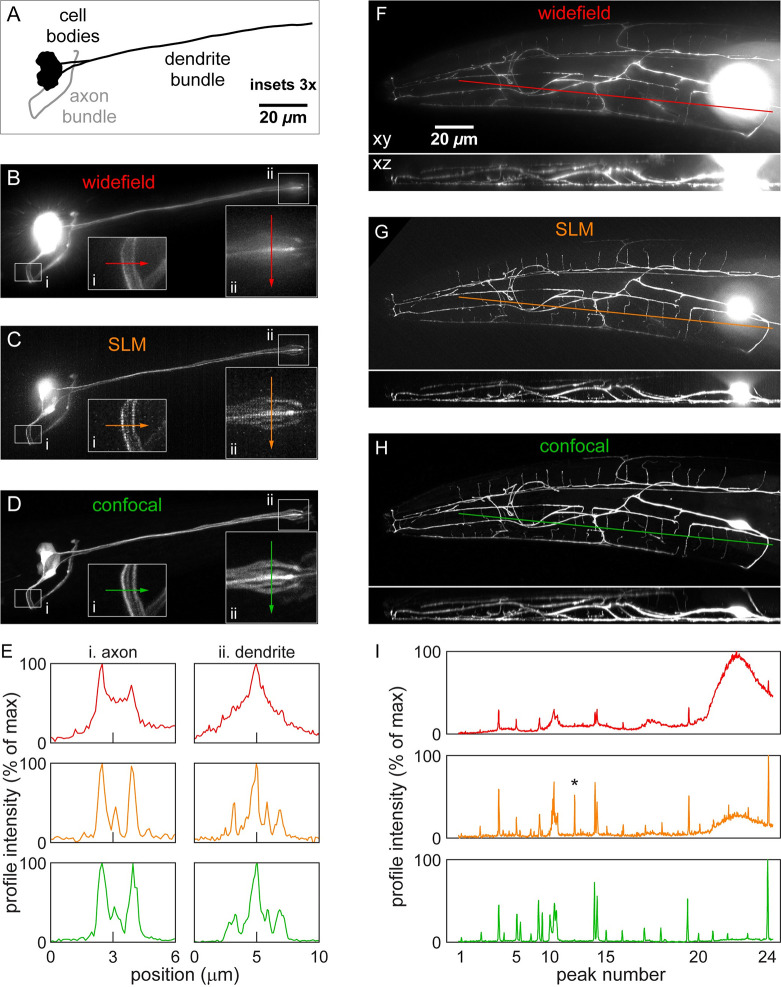
In vivo imaging of fluorescent neurons in C. elegans.(A) Line drawing of amphid neurons imaged. General location of cell bodies and neuronal fibers shown for simplicity. (B-D) Fluorescence amphid neuron images taken by widefield (B), SLM-pick (C), and confocal (D) microscopes. Insets show 3x expanded view of axons (i) and dendrites (ii) with line profiles. (E) Intensity profile of axons (i) and dendrites (ii). Peaks correspond to clear fibers in fluorescence images (B-D). Note correlation of peaks in SLM and confocal profiles and large background obscuring fibers in widefield profile. (F-H) Fluorescence images of FLP neuron taken by widefield (F), SLM-pick (G), and confocal (H) microscopes. (I) Intensity profile in images (F-H). Note correlation of peaks in SLM and confocal profiles and large background in widefield profile, particularly near cell body. Excluded peak in SLM image indicated by *. Fluorescent image normalization saturates pixels near cell body to visualize dim neuronal fibers.